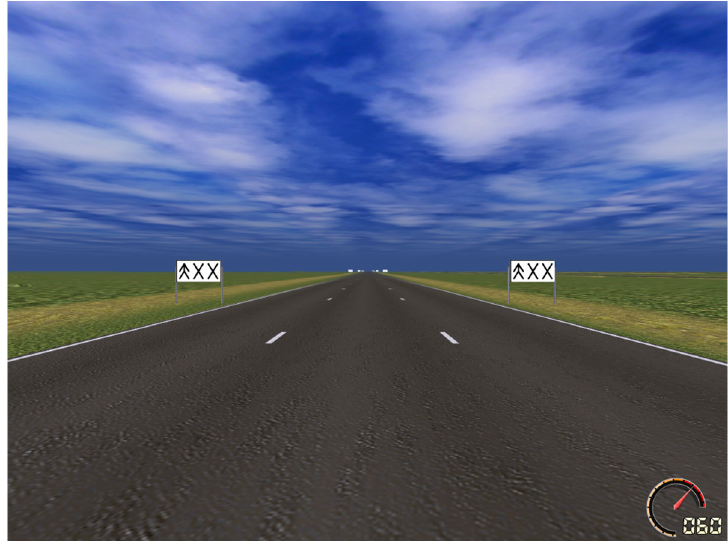
Figure 2. Screenshot in the study simulator setting of the Lane Change Task version 1.2 by Mattes [37].